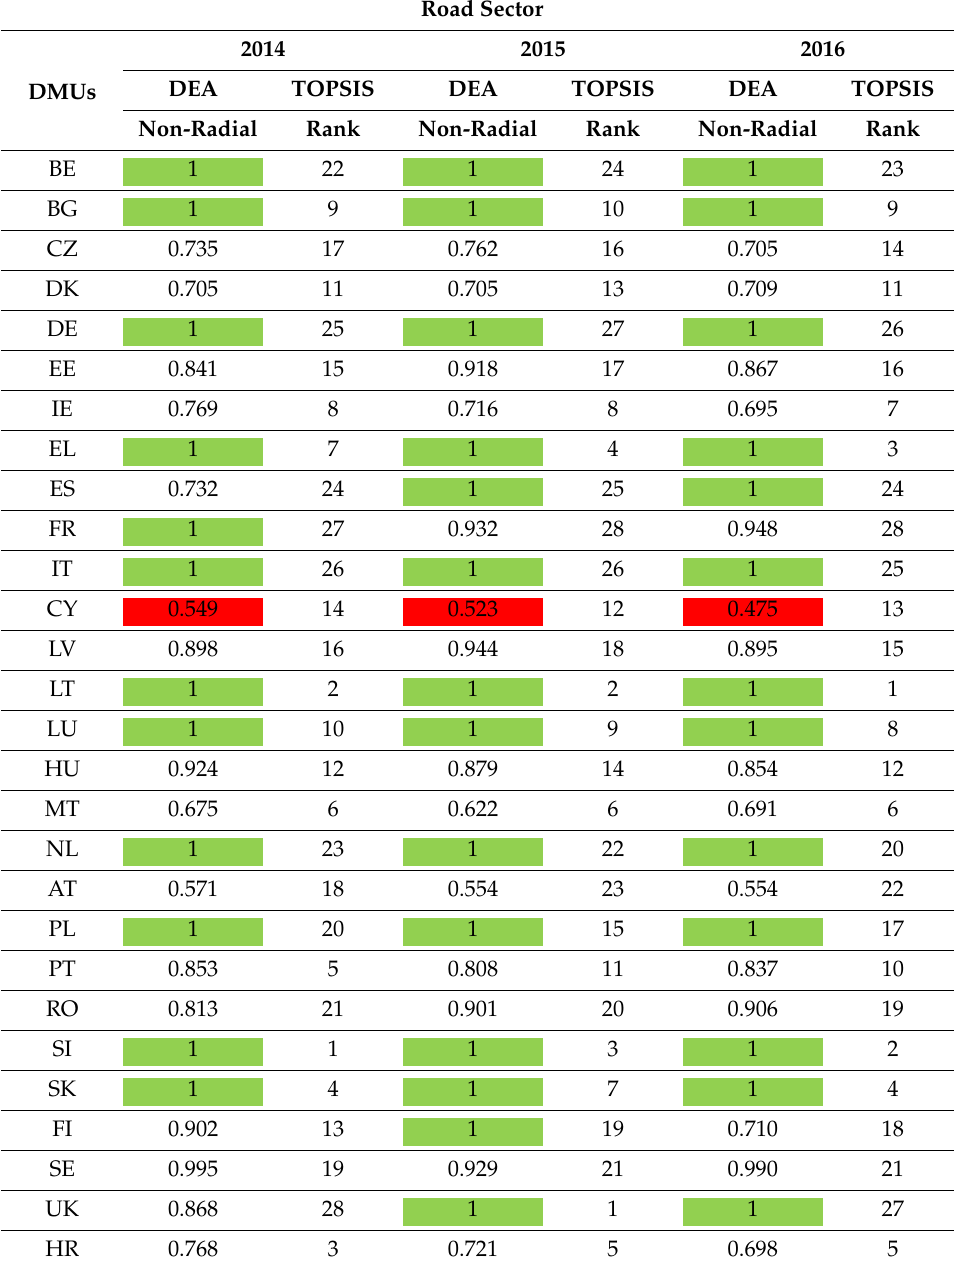
Green color: the best EEEI . Red color: the least EEEI